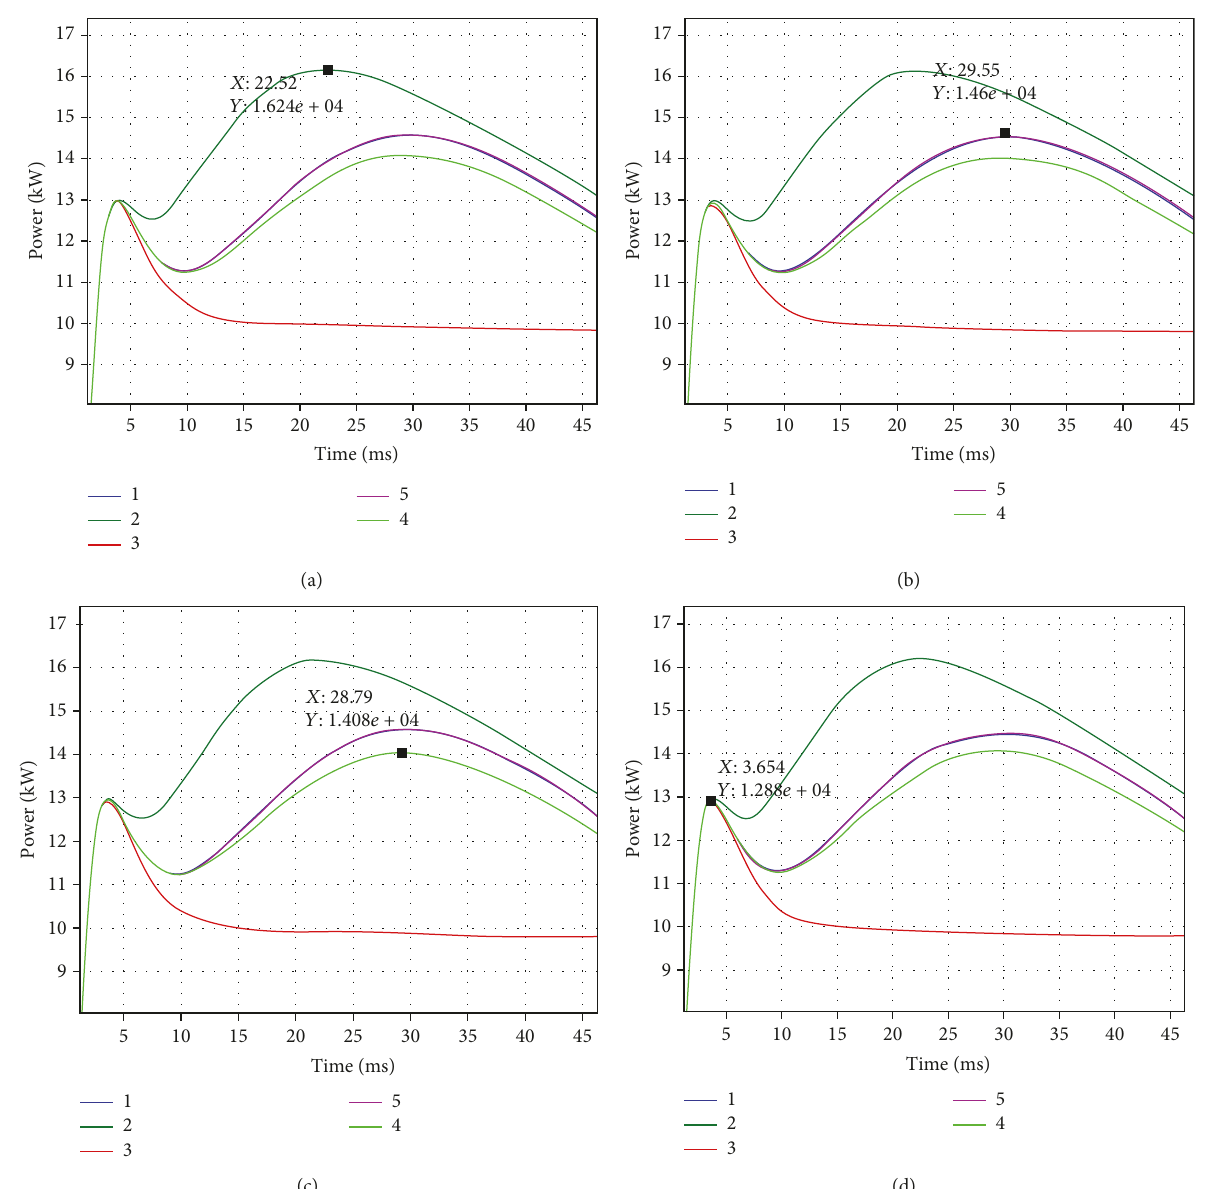
Figure 16: Comparison between maximum power of fi ve obtained